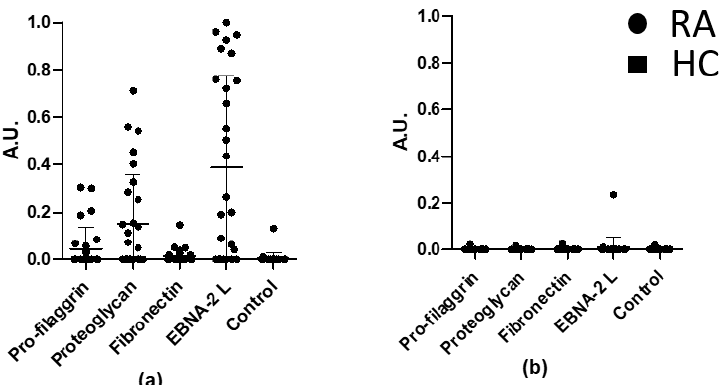
Figure 3. Reactivity of rheumatoid arthritis (RA) RA and healthy control (HC) sera to a selected peptide panel. ( a ) Screening of RA samples ( n = 28) to citrullinated peptides from pro-filaggrin, proteoglycan, fibronectin and EBNA-2. An Arg-containing pro-filaggrin peptide was used as control. ( b ) Screening of HC sera ( n = 28) to citrullinated peptides from pro-filaggrin, proteoglycan, fibronectin and EBNA2. An Arg-containing pro-filaggrin peptide was used as control. A.U. were defined as absorbances normalized relative to a positive RA control pool.